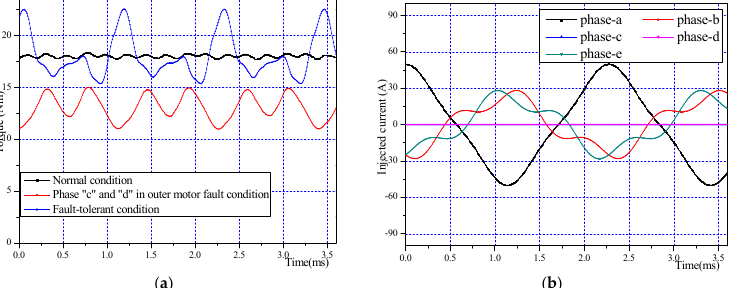
Figure 22. The motor operates under adjacent double ‐ phase open circuit in the outer motor condition: ( a ) electromagnetic torque obtained by FEA; ( b ) the injected currents of the outer motor.